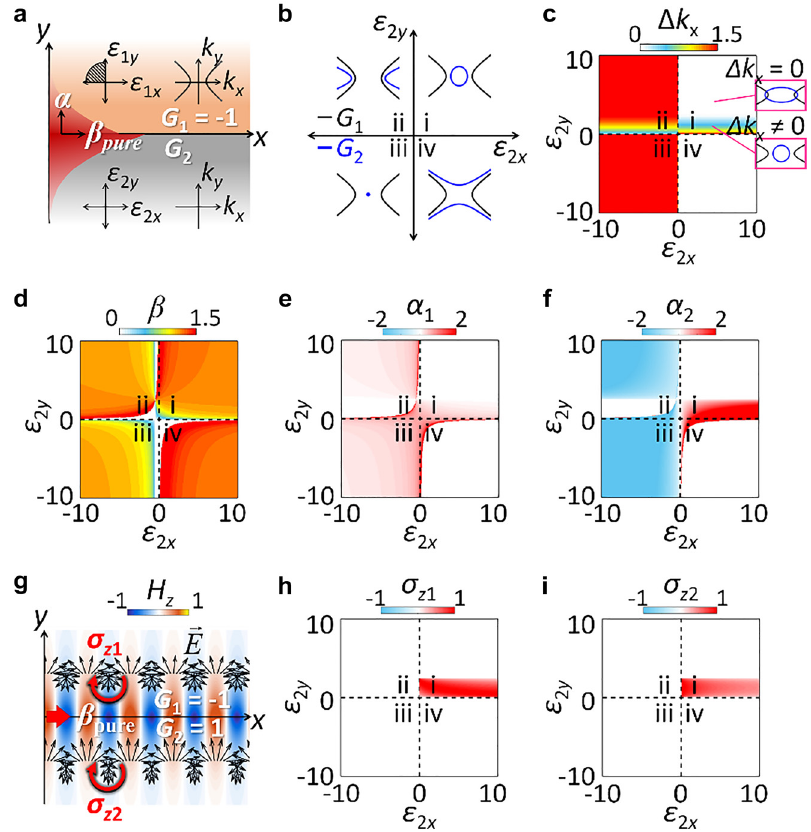
Figure 2: Lifshitz interface at the same IFC dimensionality. (a) An interface between a hyperbolic-I layer ( G 1 = − 1) and a varying layer ( G 2 ). (b) Four quadrants of IFCs in the material parameter space (i: G 2 =1,ii: G 2 = − 1,iii: G 2 = s ,iv: G 2 = − 1)withthehyperbolic-Itoplayer( G 1 = − 1).(c – f)Phasediagramsfor(c)wavevectorgap Δ k x ,(d)propagation constant β ,and(e andf)decay factorsof (e) α 1 and(f) α 2 . (g)Magnetic fi eld pro fi le H z fora pure T-spinmode at theLifshitzinterfacehavingthe sameIFCdimensionality( G 1 = − 1with ε 1 x = − 0.5, ε 1 y =2.5,and G 2 =1with ε 2 x =0.5 ε 2 y =1.5).Blackandredarrowsdenote E - fi eldandtheT-spin handedness, respectively. (h and i) Phase diagrams for T-spin density σ z 1 and σ z 2 . In (c – f, h, and i), the top layer has ε 1 x = − 0.5 and ε 1 y =